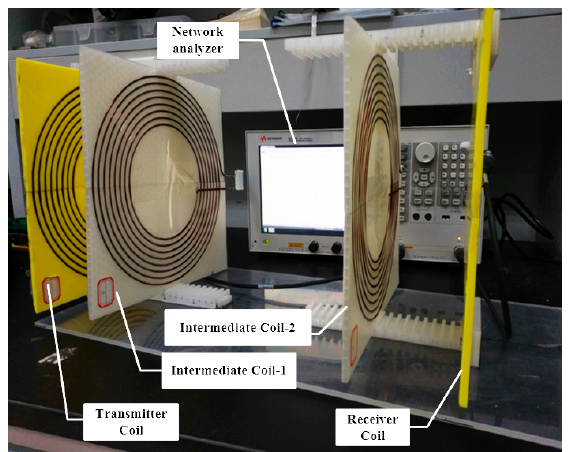
Figure 8. Parameters S 21 were measured by a network